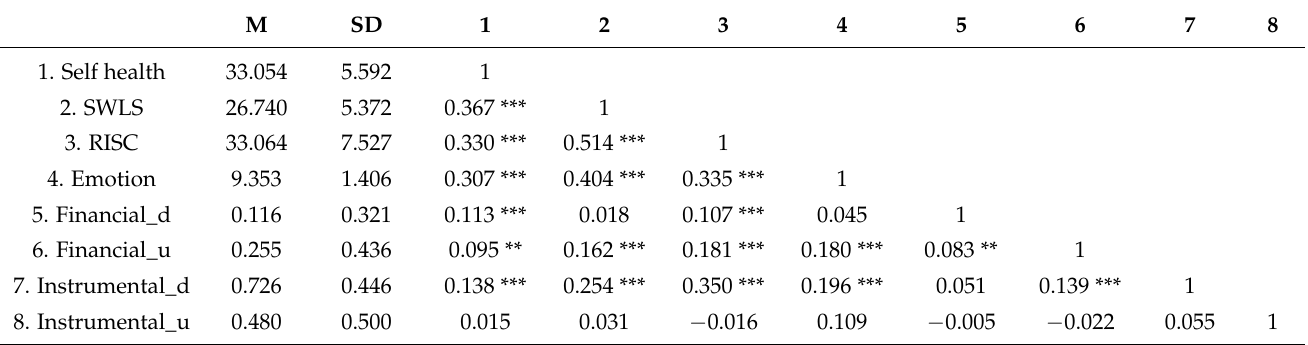
Table 2. Bivariate correlations among key variables.